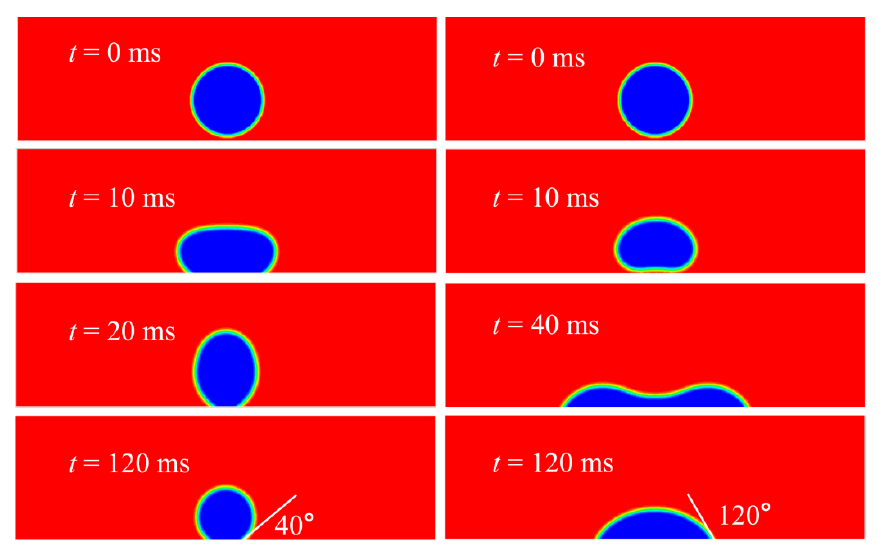
Figure 5. Contact angle validation on surfaces of varied wettabilities.